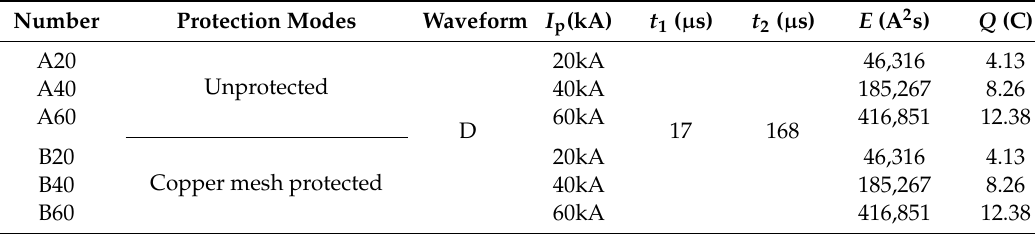
Table 3. Combinations of currents and protection modes. Meanings of I p , t 1 , and t 2 are, respectively, shown in Figure 4b; E is the integral action; Q is the charge transfer.